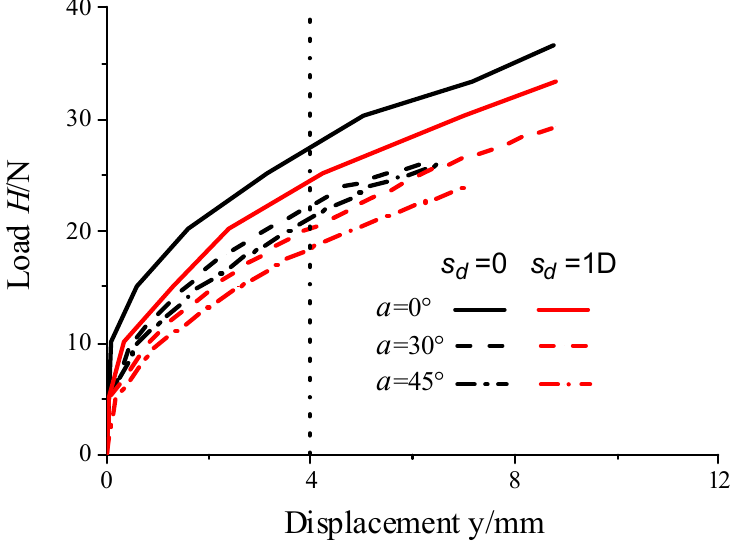
Figure 10. Load–displacement curves for monotonic tests.